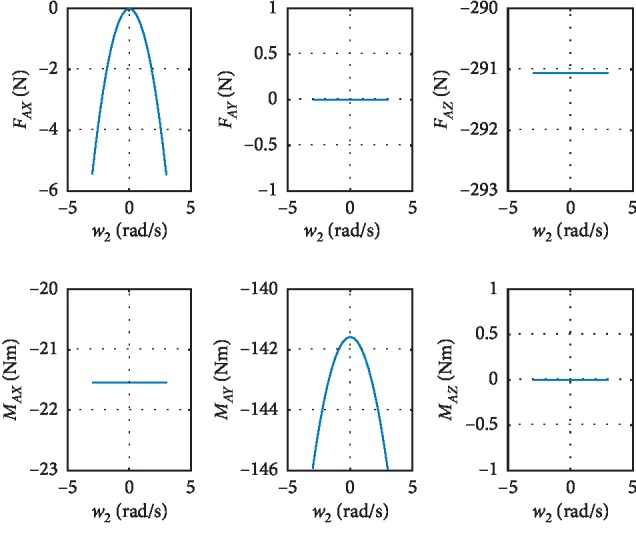
The influence of ω4 on the forces: FAx,  FAy and FAz and the moments: MAx,  MAy and MAz.